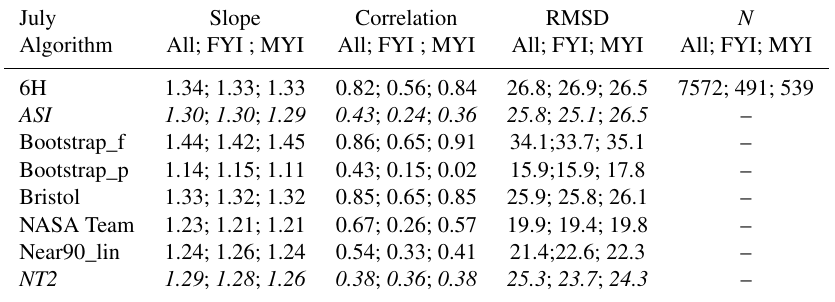
Table 9. Statistical parameters of the comparison AMSR-E sea-ice concentration vs. MODIS ice-surface fraction for MODIS sea-ice concen- tration > 90% (see Fig. 5) for July 2009. Each column gives the value for all grid cells with MODIS sea-ice concentration > 90%, and the respective multiyear (MYI) and first-year ice (FYI) grid cells. Values obtained for the ASI and NT2 algorithm are shown for completeness but are in italic font.